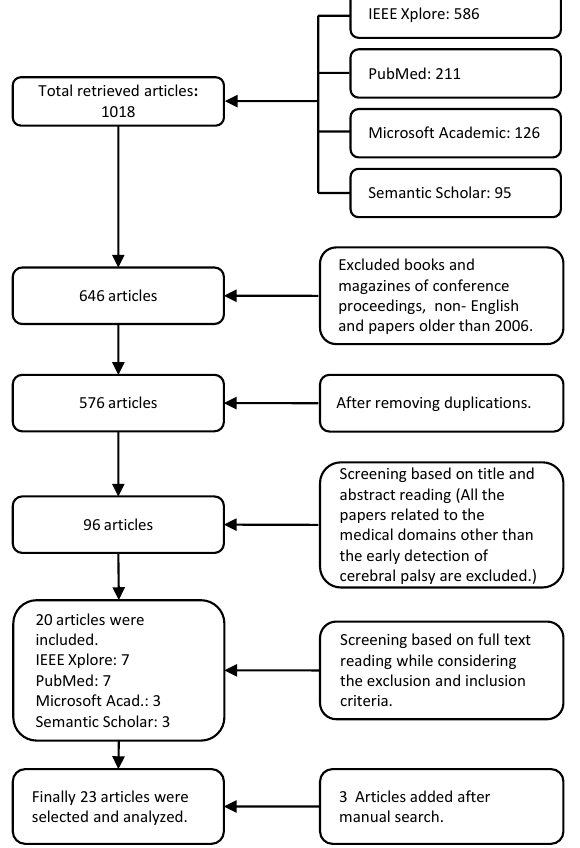
Figure 1. The procedure of literature selection and